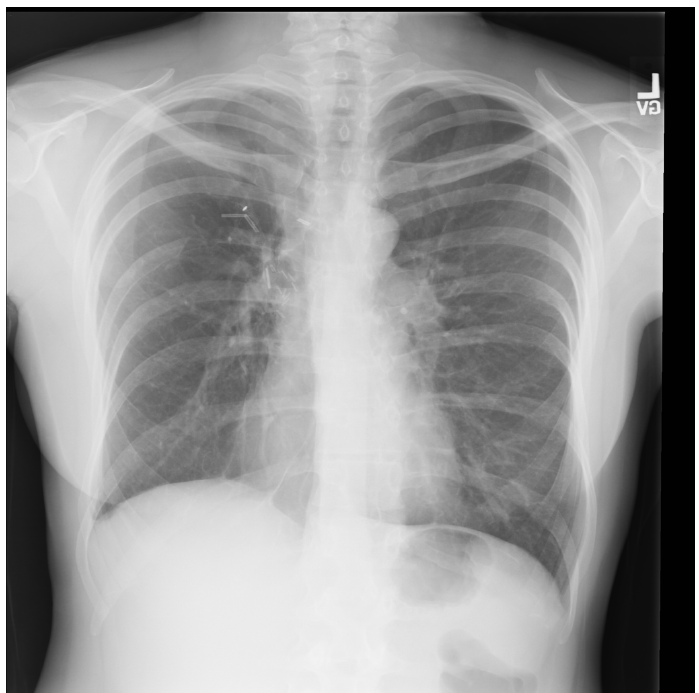
Figure 13. Normal sample: synthetic-covid-cxr.